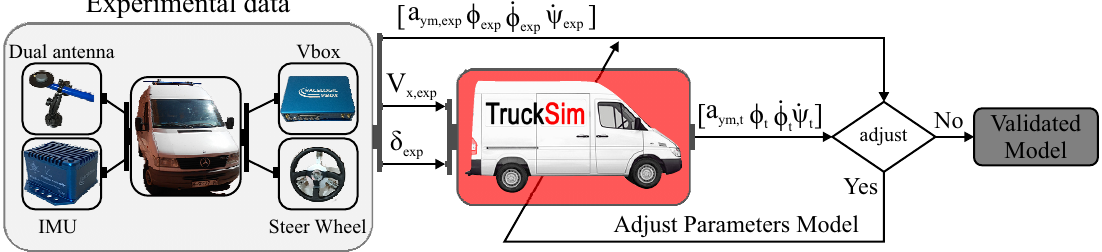
Figure 5. Scheme of the vehicle model